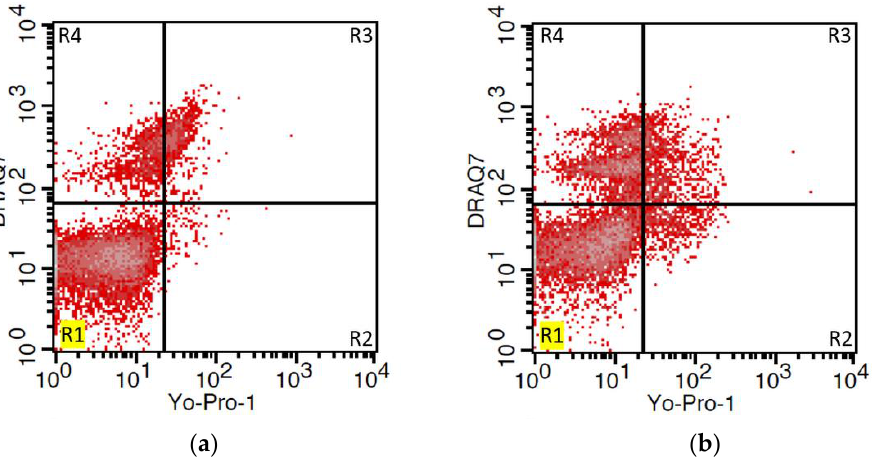
Figure 1. Expression of apoptotic and dead markers in fresh ( a ) and F/T ( b ) ram semen samples. Representative dot plots gated by regions showing the ratio of live sperm (unstained: Yo-Pro- 1 − /DRAQ7 − ) (R1), apoptotic (Yo-Pro-1 + /DRAQ7 − ) (R2), and dead (Yo-Pro-1 + /DRAQ7 + and Yo-Pro- 1 − /DRAQ7 + ) (R3, R4) sperm.